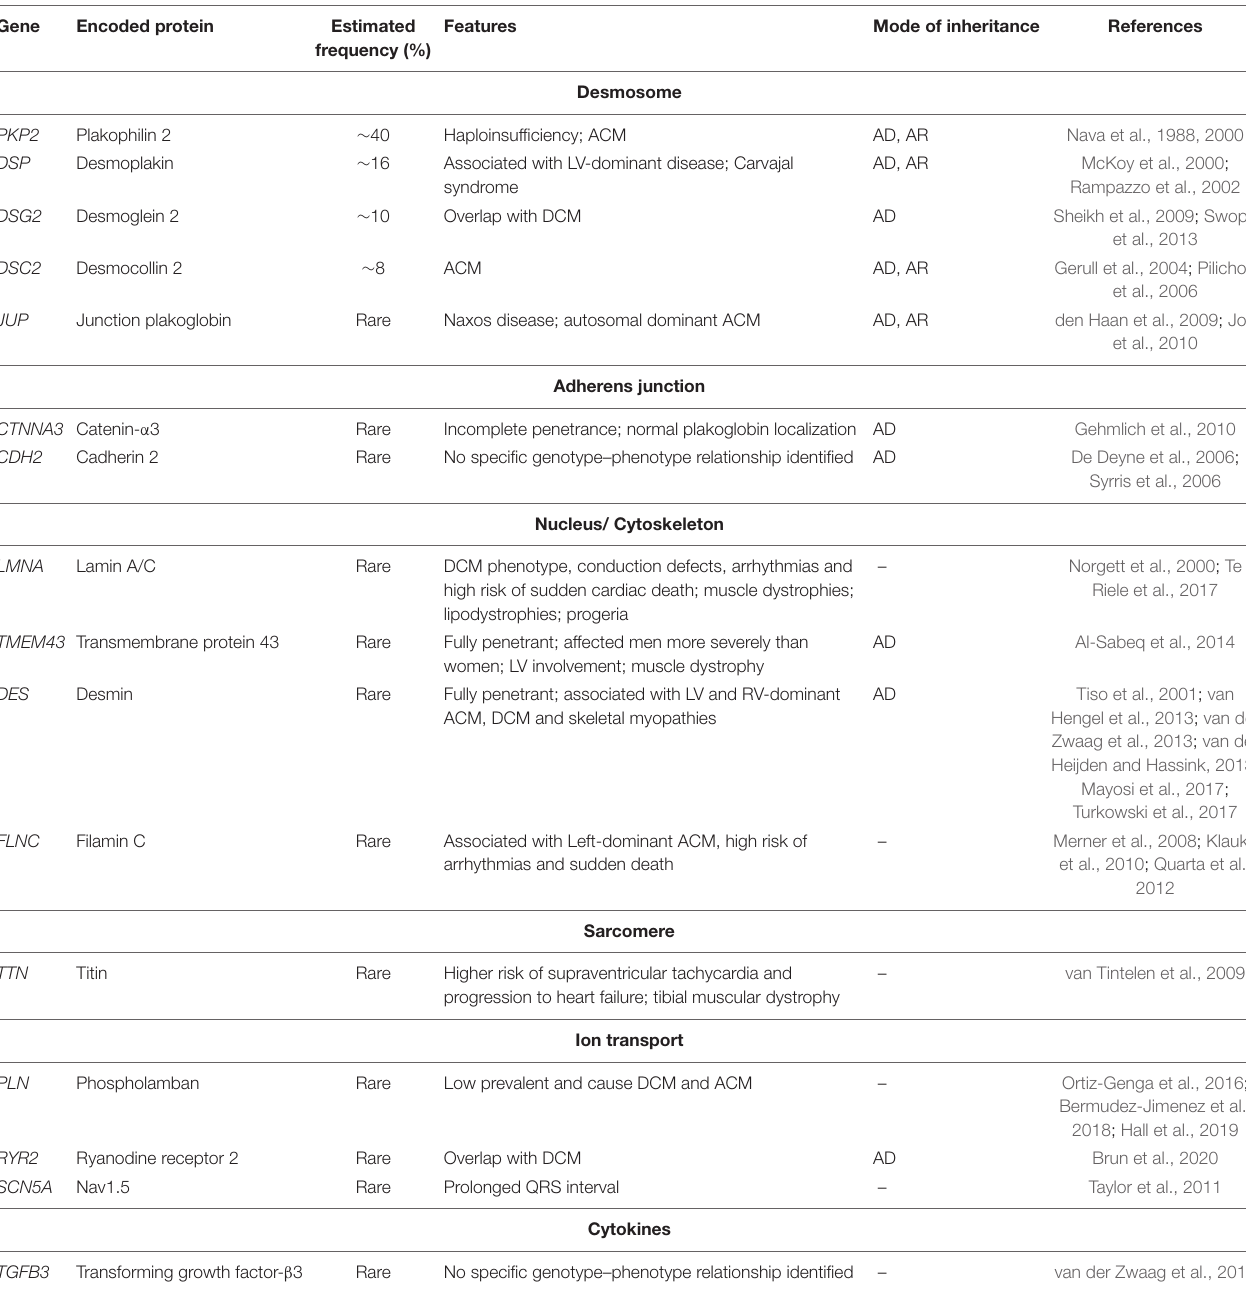
TABLE 1 | List of causal genes for